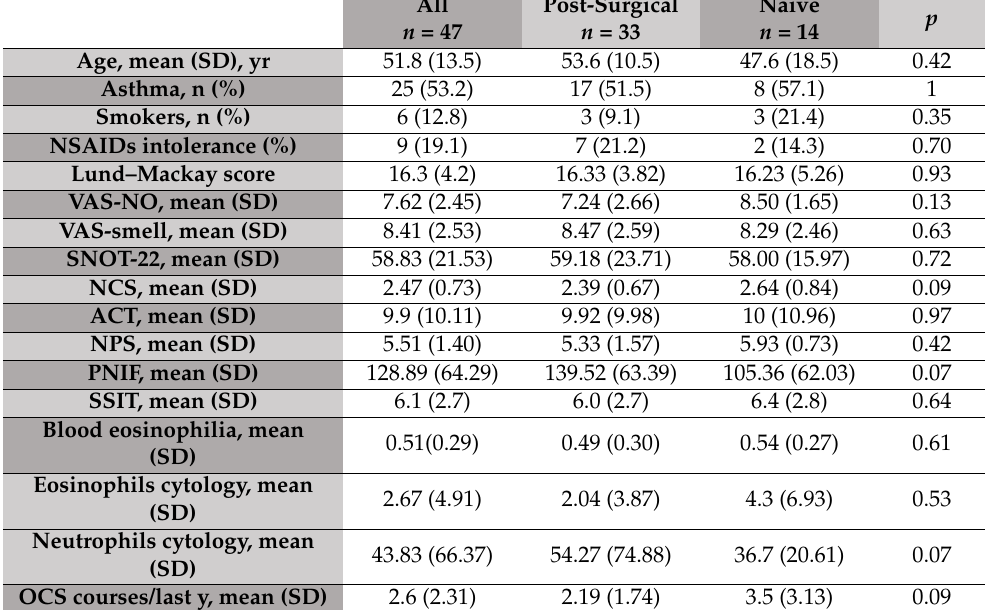
Table 1. Patients’ main clinical characteristics, values of the objective measurements and evaluation of symptoms at the baseline for the whole group and for the post-surgical and the naïve groups separately. P -value is referred to as the differences between the post-surgical and the naïve groups. All n =